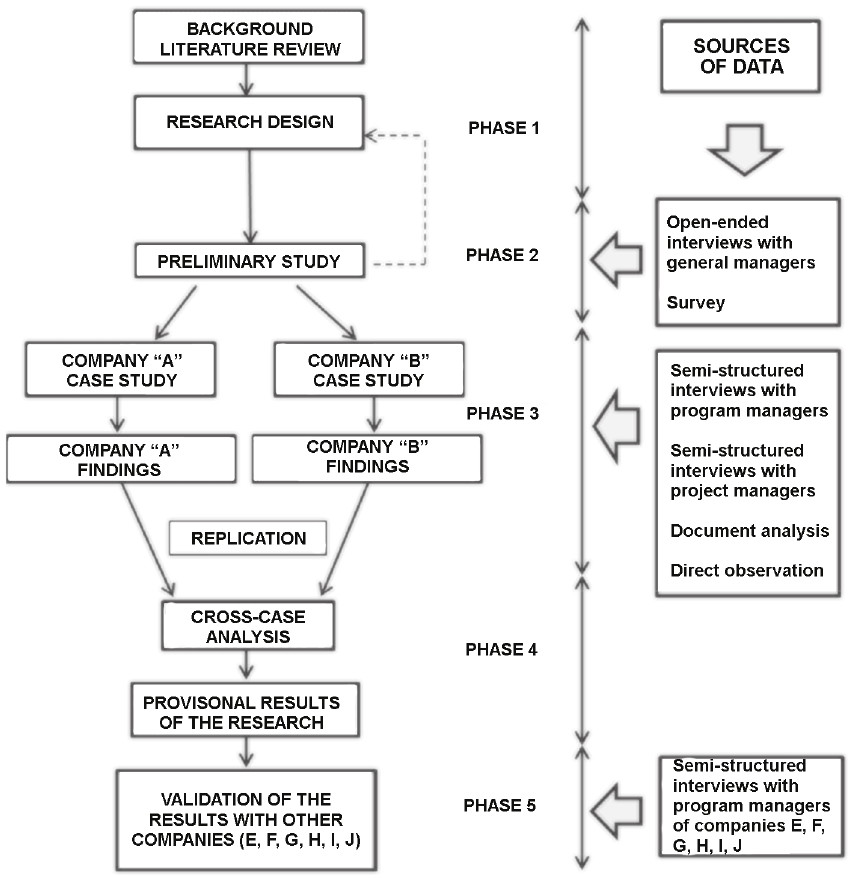
Figure 1. Outline of the research